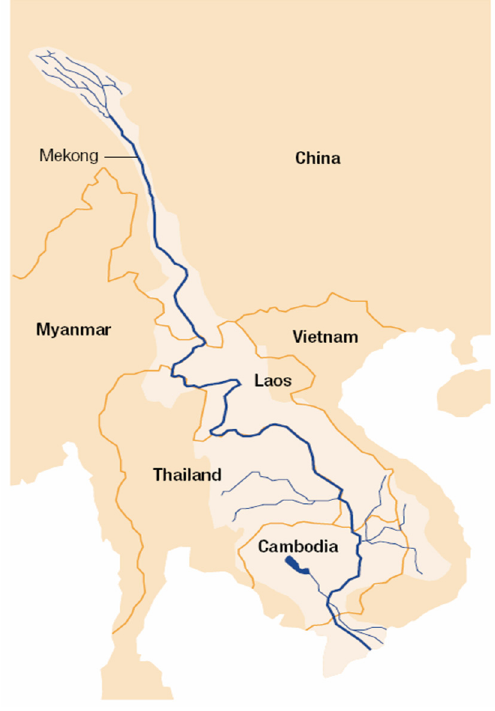
Figure 1. Member countries of LMC.